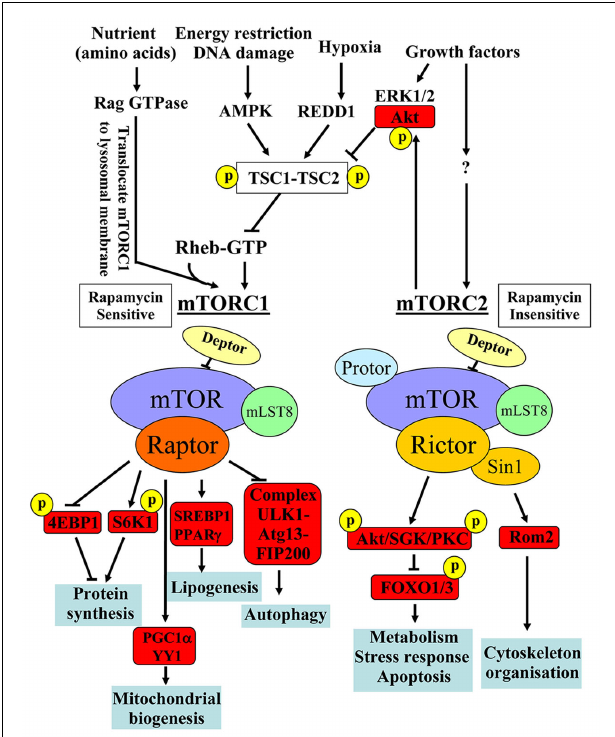
FIGURE 1 | Major distinct characteristics of the two known mTOR signaling complexes, mTORC1 and mTORC2, in composition, rapamycin sensitivity, upstream signals, substrates, and biological functions. Adapted from Foster and Finger (2010) and from Zoncu et al. (2011). 4E-BP1, eIF4E-binding protein 1; AMPK, AMP kinase; Atg, autophagy-related; FIP200, 200kDa FAK family kinase-interacting protein; FOXO, forkhead box protein O; PPAR γ , peroxisome proliferator-activated receptor- γ ; REDD1, regulated in development and DNA damage response 1; Rom2, Rho1 GDP–GTP exchange protein-2; SGK, serum- and glucocorticoid-regulated kinase; SREBP, sterol regulatory element-binding protein;TSC, the tuberous